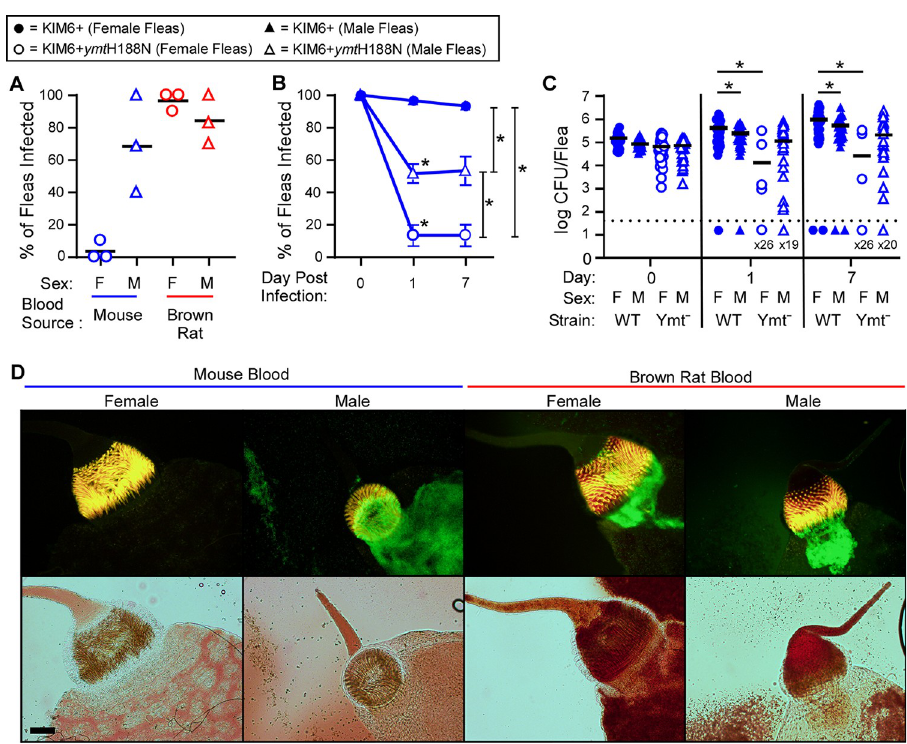
Fig 3. The Y . pestis Ymt mutant colonizes male fleas more efficiently than females following infection using mouse blood. Infection rates for groups of female or male X . cheopis infected using mouse blood (blue symbols) or